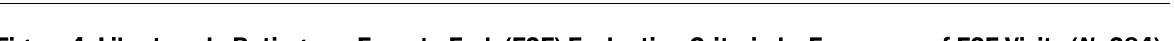
Figure 4. Likert-scale Ratings on Farm-to-Fork (F2F) Evaluation Criteria by Frequency of F2F Visits ( N